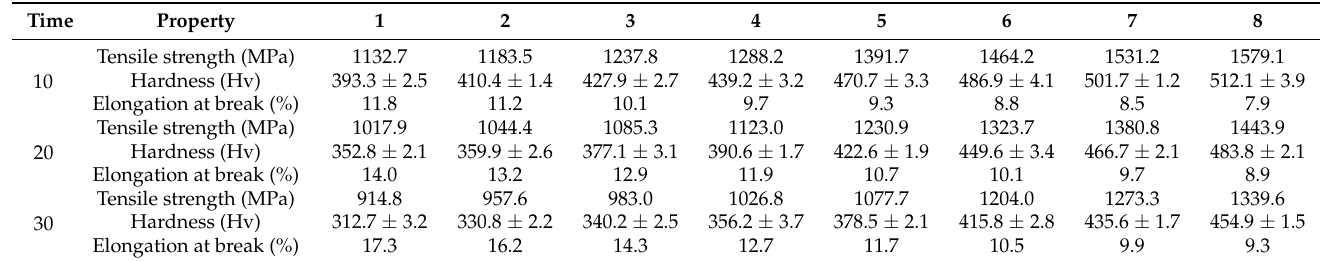
Table 4. Hardness, tensile strength, and elongation at break of sheet at different temperature measur- ing